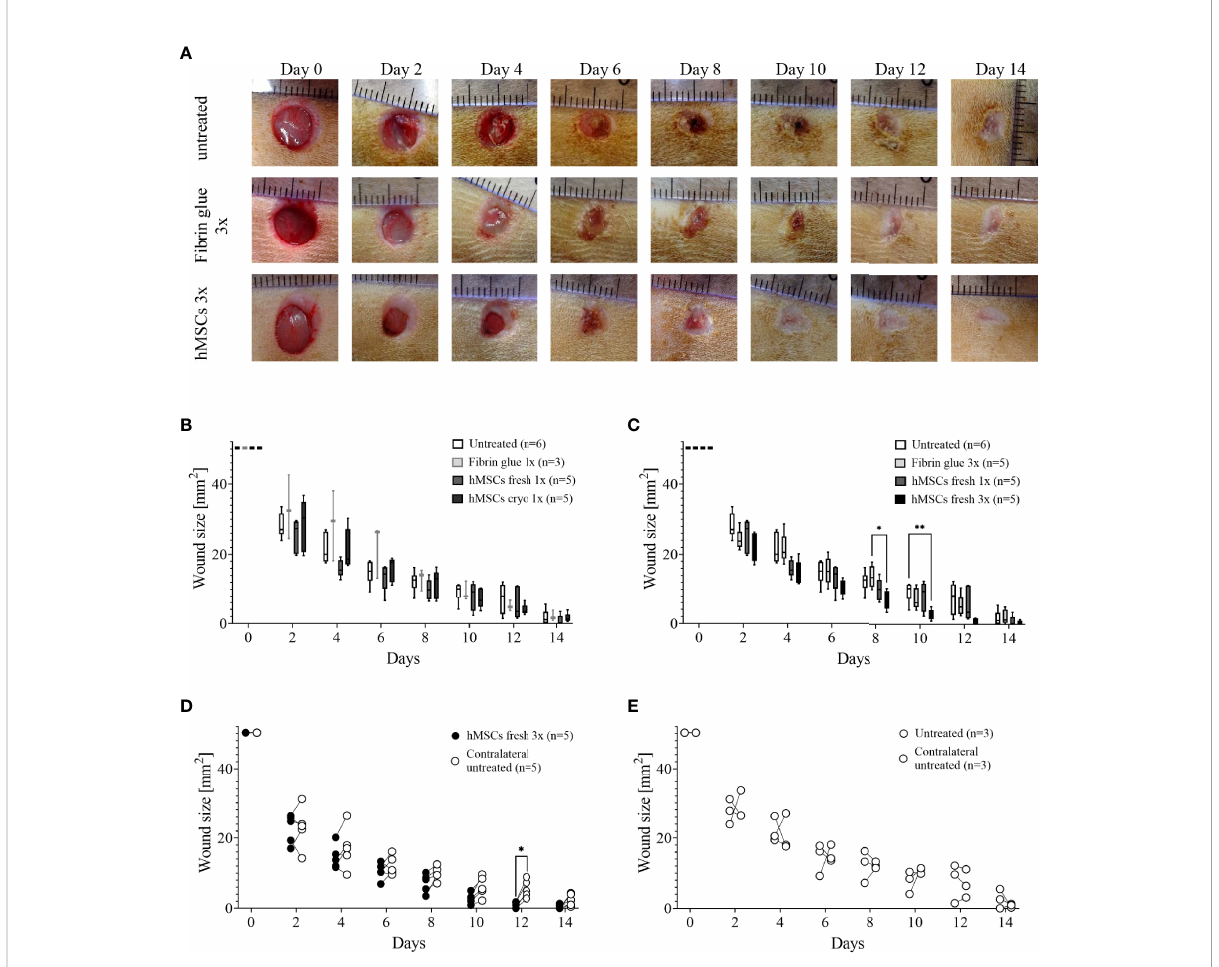
FIGURE 4 Pilot studies 1-3 to assess cryodamage, dose fi nding and systemic wound healing effects. (A) Representative images of wounded skin after single topical treatment with either hMSCs in fi brin glue, cell-free fi brin glue or untreated at d0 after wounding. (B) Wound area reduction after topical treatment with either untreated, cell-free fi brin glue and hMSCs thawed (cryo) or from rescue culture (fresh), (C) Single versus 3-times repeated hMSCs administration (1x versus 3x fresh, d0, 4 and 8). Quanti fi cation of wound areas relative to initial wound area was performed with Image J. Data are presented as min to max box-whisker plots denoting the median. (D, E) Comparison of wound size reduction of contralateral untreated wounds with lateral either hMSCs (D) or untreated wounds (E) . Side-by side comparison of hMSCs fresh vs. contralateral untreated and untreated vs. contralateral untreated shown. *p ≤ 0.05, **p ≤ 0.01 as calculated using two-way ANOVA und Tukey multiple comparisons. fresh, MSCs from max. 2 days of rescue-culture before administration to the wounds; cryo, MSCs thawed immediately before application; 1x, single application day 0; 3x, repeated application d0, day 4 and day